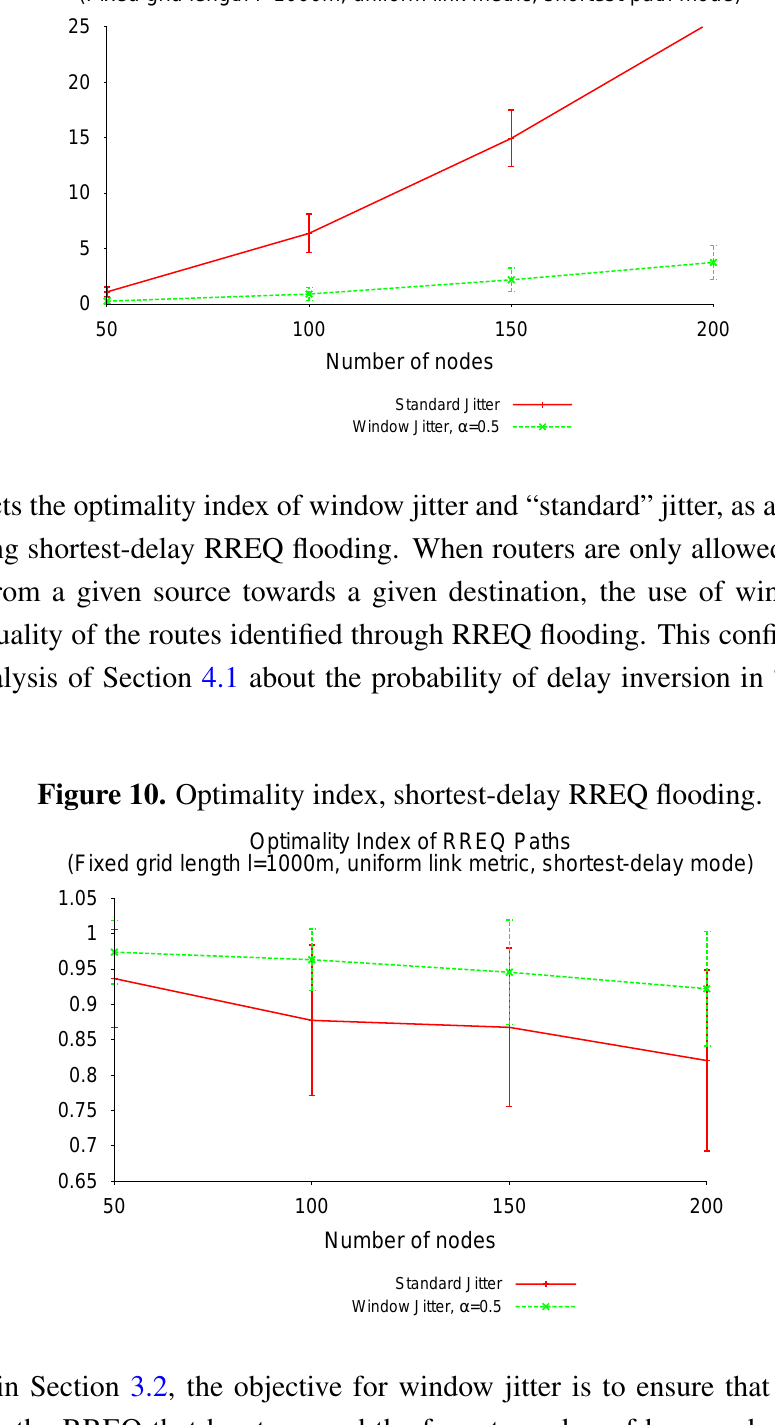
Figure 9. Number of collisions, shortest-path RREQ (Route Request) flooding.